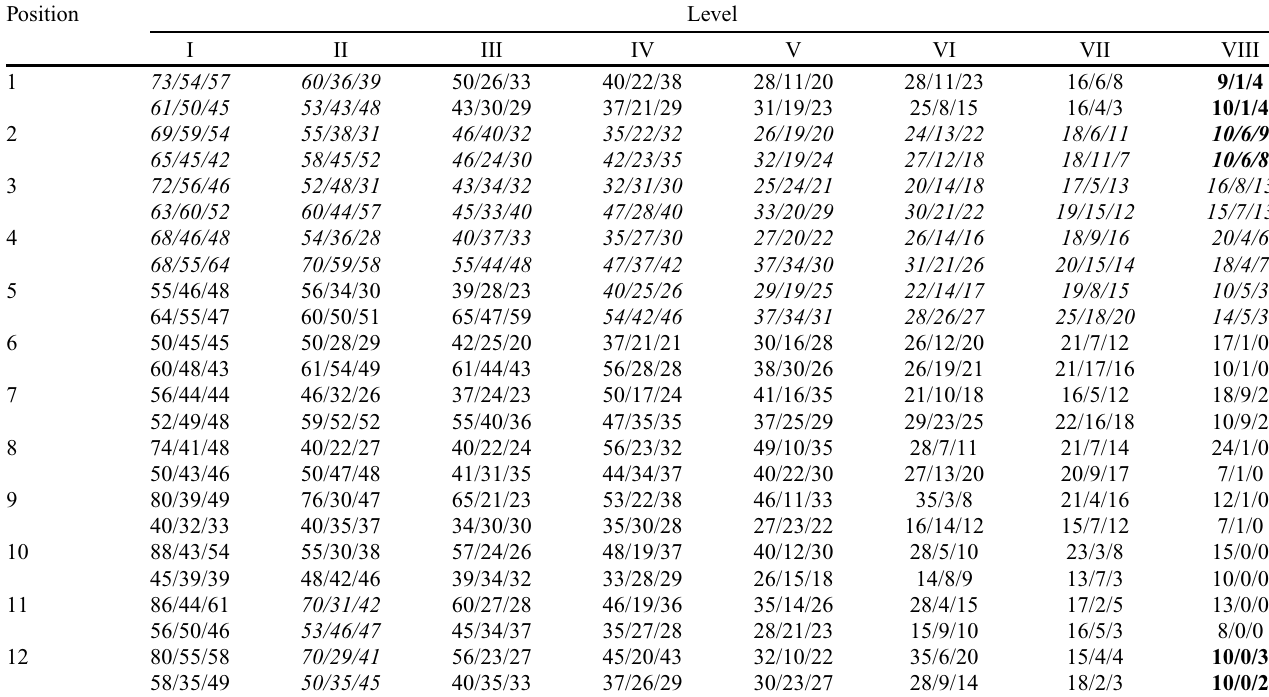
Table 3. Displacement of skin/fascia/muscles [mm] relative to the radius at 70 (cid:2) of pronation and 70 (cid:2) of supination. Position Level